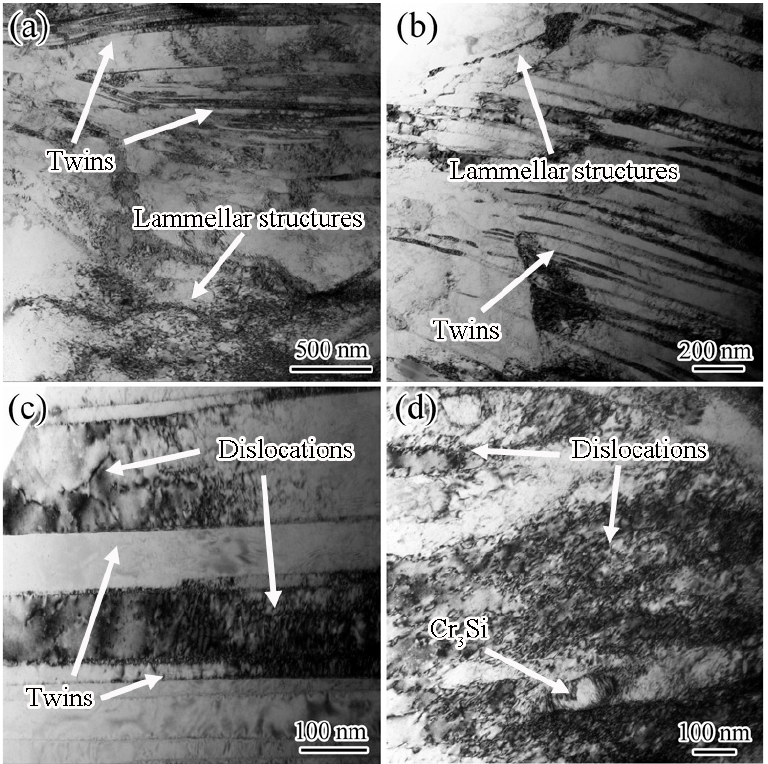
Figure 5. TEM images of CR CuNiSi-0.30Cr alloys: ( a ) low magnification, ( b ) deformed structures and twins, ( c ) twins and ( d ) deformed structures.